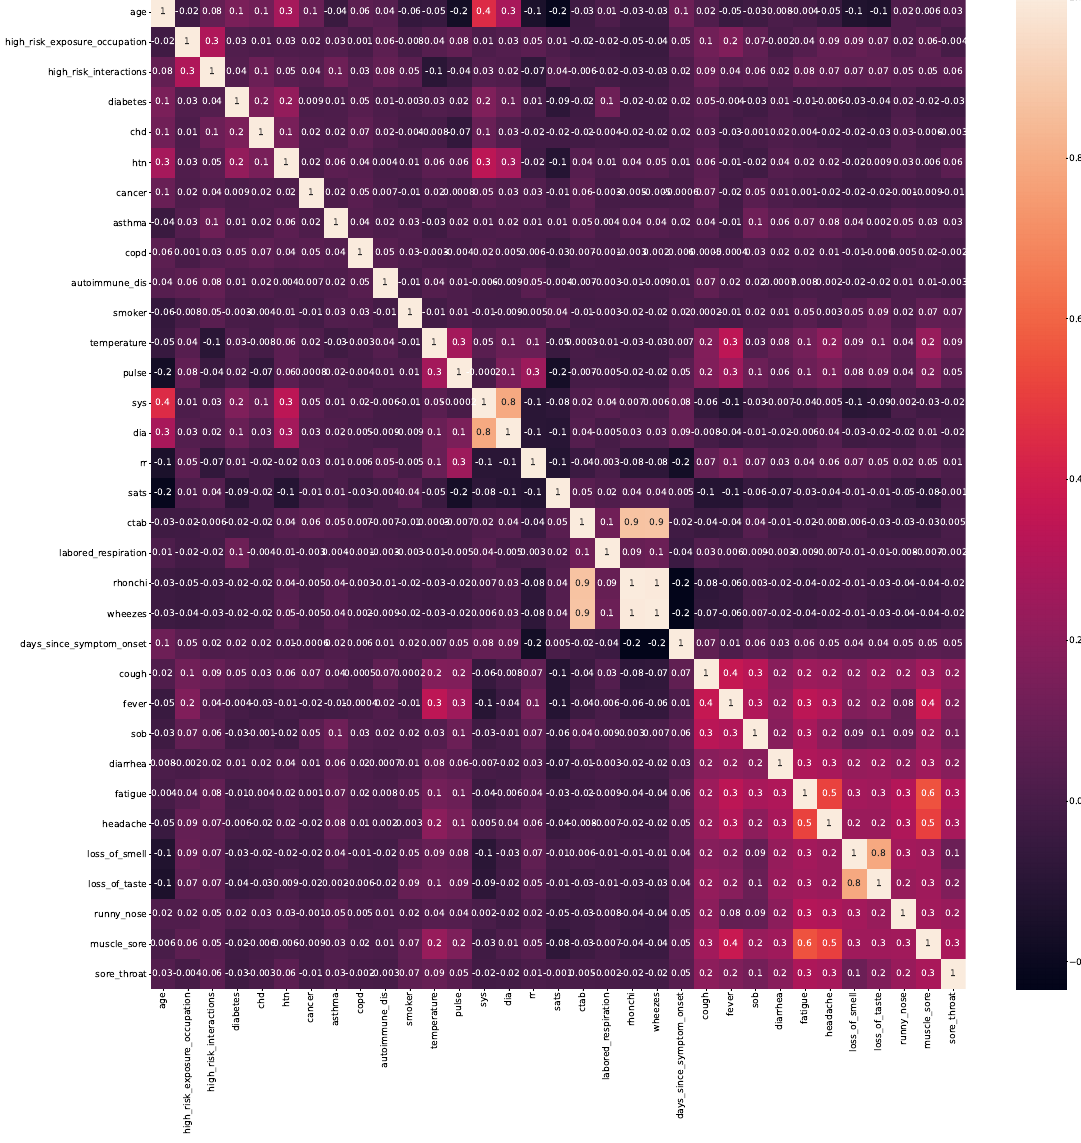
Figure 2. Heat–map representation of the features, dispensing the correlations between